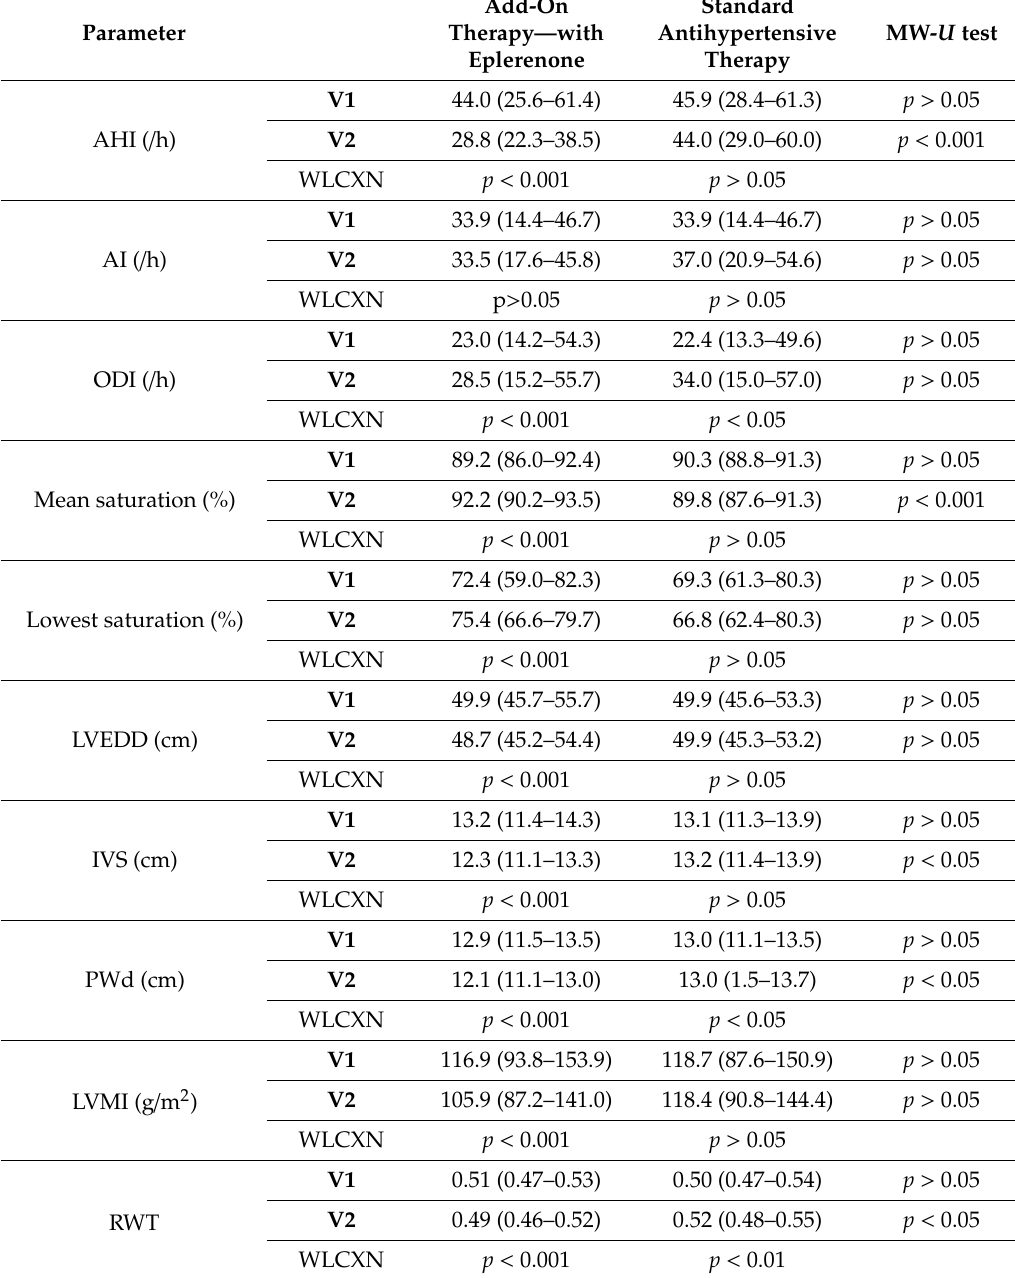
Table 4. The polysomnographic and echocardiographic parameters observed for patients assigned to add-on treatment with eplerenone (50 mg / day) and standard hypertensive treatment before (V1) and after 6 months (V2). All values are reported as median (interquartile range). The statistical comparison of parameters before (V1) and after treatment (V2) were conducted with Wilcoxon test (WLCXN) while the eplerenone versus standard hypertensive treatment comparison was conducted with Mann–Whitney U test (MW- U